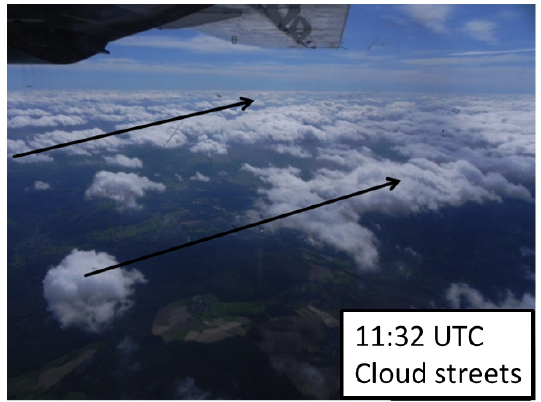
Figure 12. Cloud formation below the flight track at about 11:32UTC. Just before measuring a profile by descending above Mount Kleiner Feldberg. The arrows show the mean wind